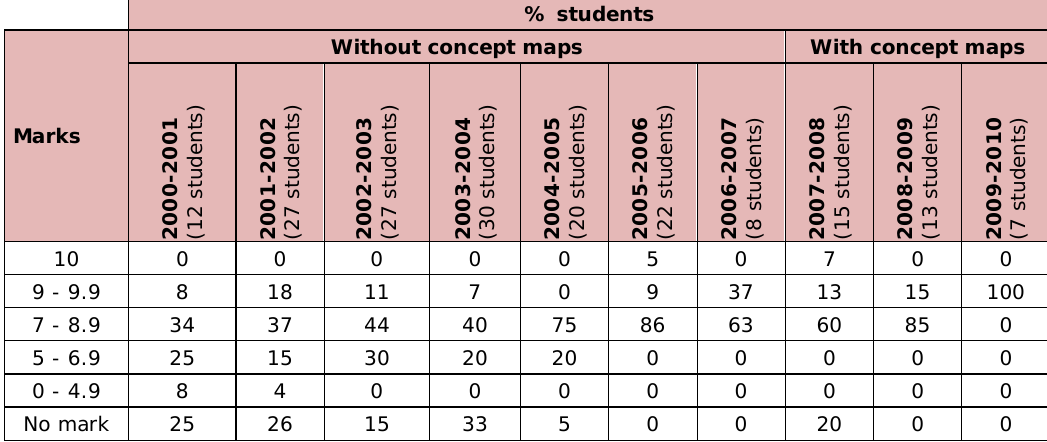
Table 2. “Final marks of the subject Analytical Techniques of the